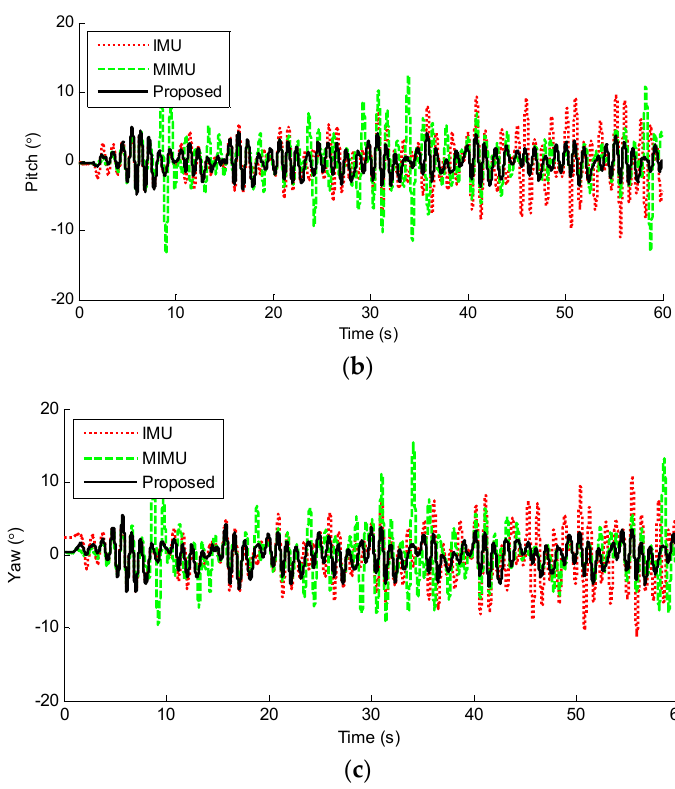
Figure 11. Euler angles converted from quaternion error among IMU algorithm, MIMU algorithm and proposed method from one example trial. ( a ) Roll angle; ( b ) Pitch angle; ( c ) Yaw angle.